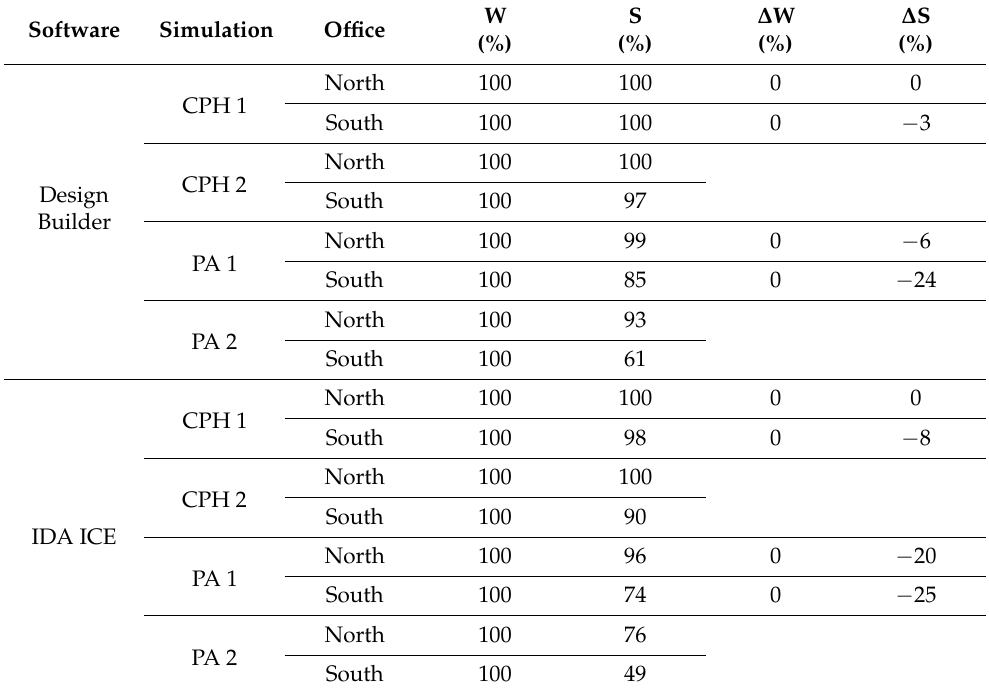
Table 3. Percentage of time when t o is above 20 ◦ C during winter and when t o is below 26 ◦ C during summer, calculated with Equations (6) and (7). W: winter; S: Summer; ∆ W: percentage the of difference between scenario 1 and 2 in winter; ∆ S: percentage of the difference between scenario 1 and 2 in summer, calculated considering scenario 2 as